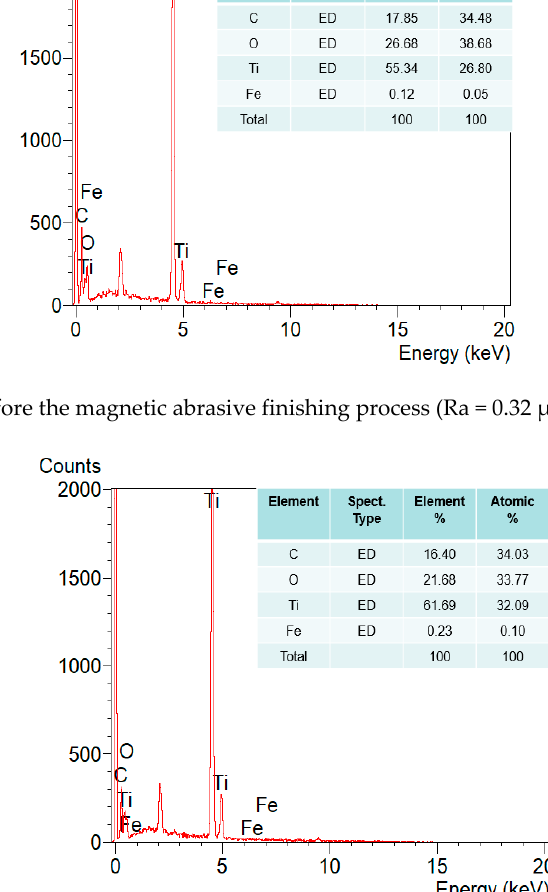
( b ) Figure 11. EDS chemical composition mapping of before and after processing the workpiece: ( a ) before finishing Ra = 0.32 and ( b ) after finishing Ra = 0.08. Table 4. Chemical composition of β -titanium wire before and after finishing.